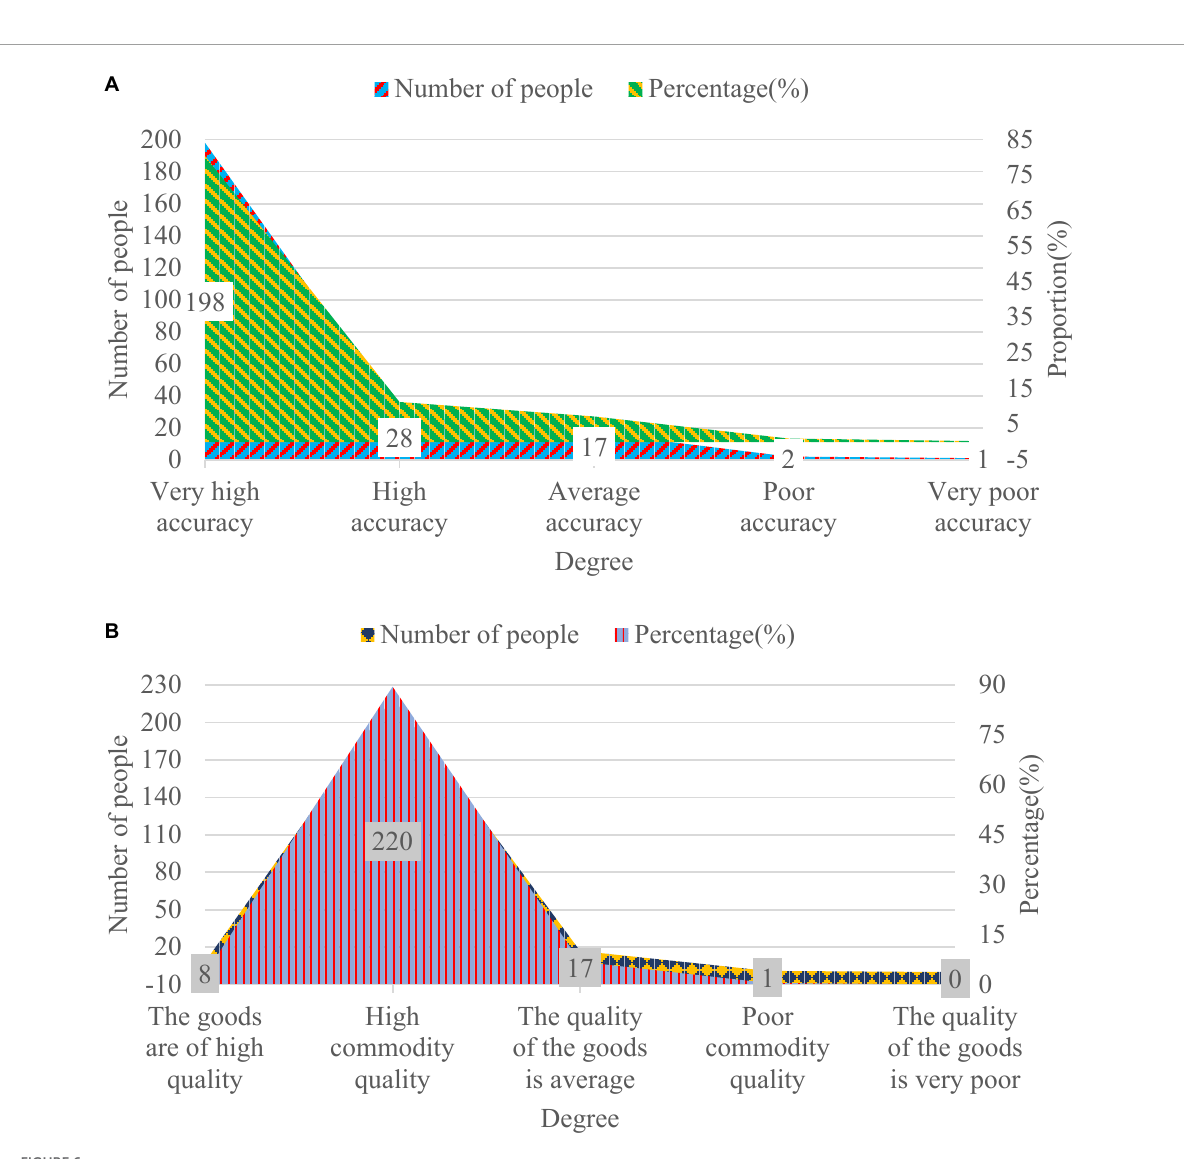
FIGURE6 Respondents’ evaluation of the quality and accuracy of goods. Panel (A) shows the correctness of the quantity and type of goods purchased. Panel (B) shows the quality of